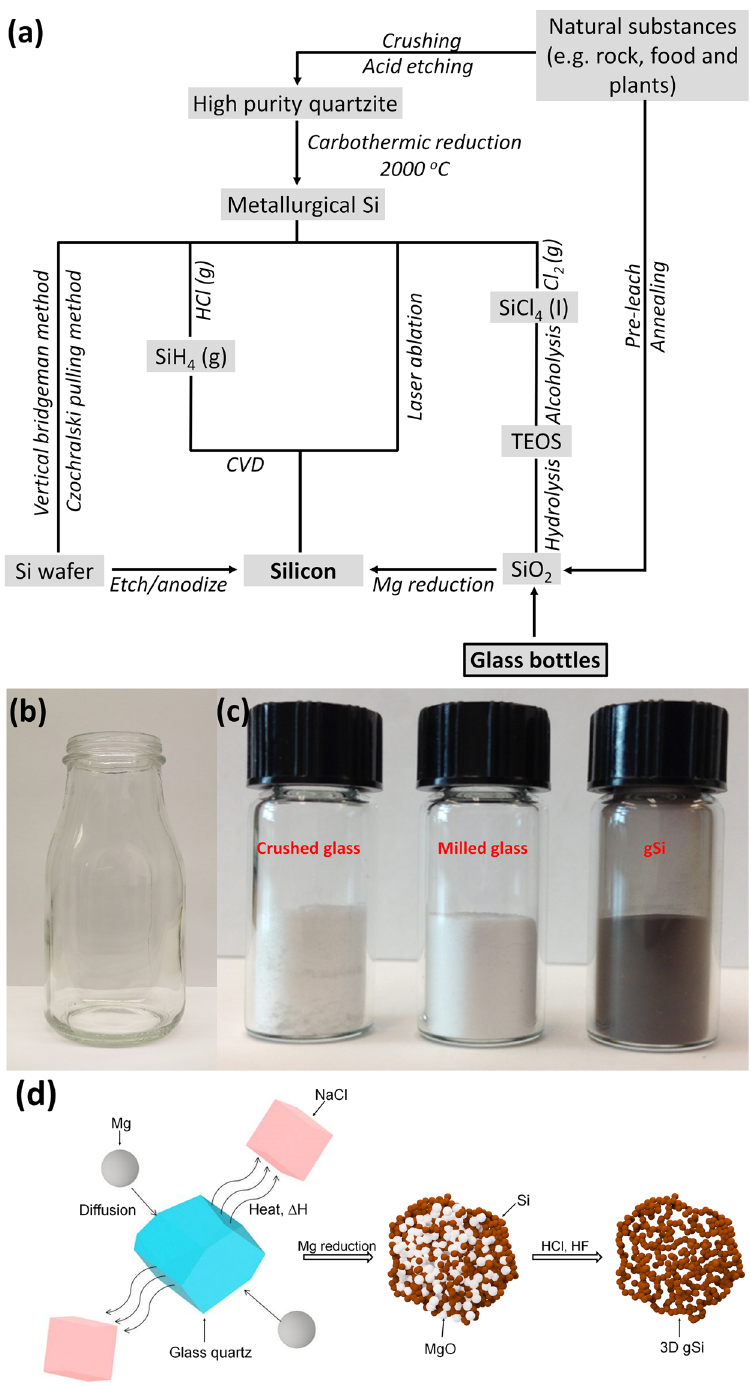
Figure 1. ( a ) Flow chart showing existing synthesis routes for nano-Si, including our synthesis method from glass bottles. ( b ) A collected beverage glass bottle. ( c ) (From left to right) vials of crushed glass, milled glass and gSi powder. ( d ) Schematic of the Mg reduction process using NaCl as heat